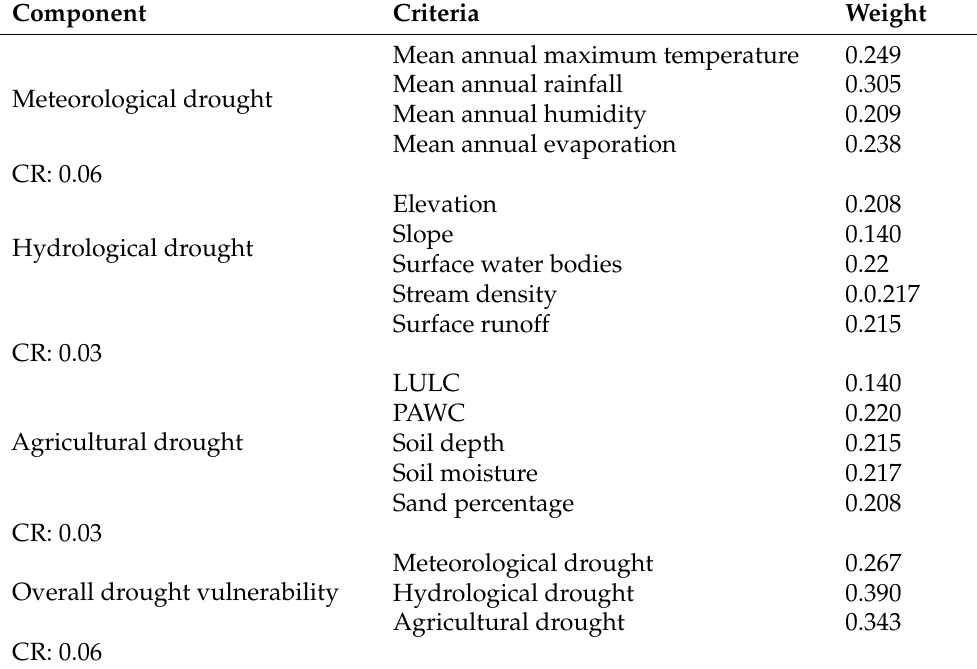
Table 3. Criteria weights and CR